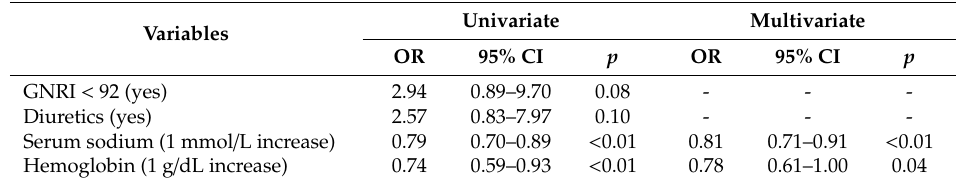
Table 2. Univariate and multivariate analyses of factors associated with increased in-hospital mortality in patients with HFrEF.